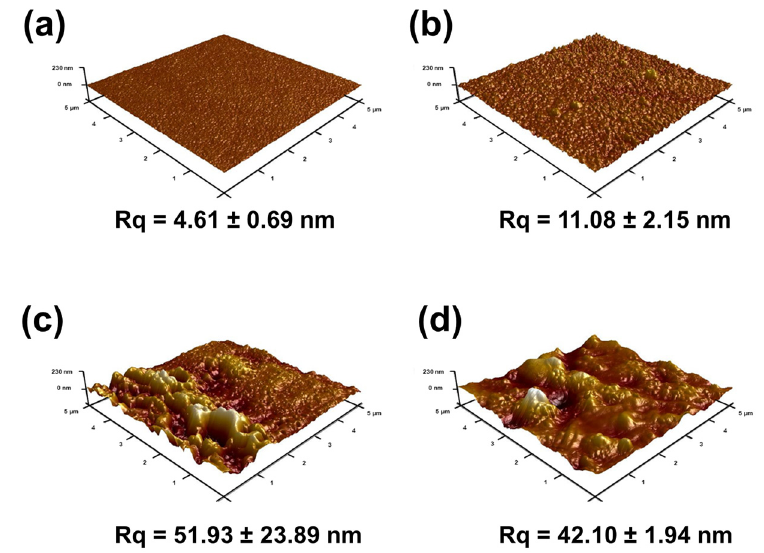
Figure 7. Three-dimensional atomic force microscopy (AFM) images of ( a ) PSf, ( b ) TFC, ( c ) TFN Na-MMT and ( d ) TFN O-MMT . Particle concentration = 0.05 g O-MMT/ g TMC.